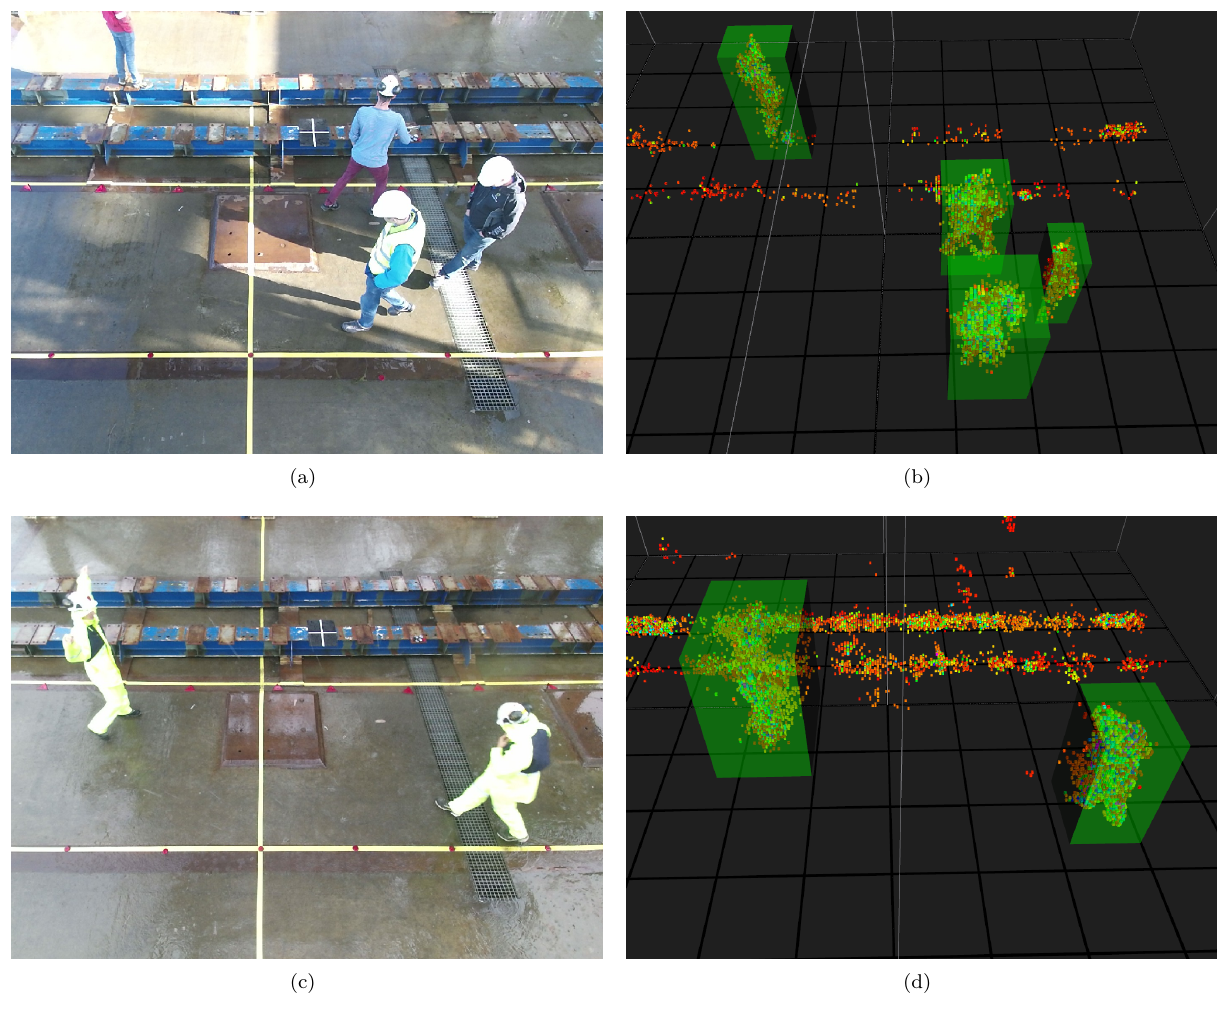
Figure 5: Detection test on Outdoor Data - (a) and (b) Four people present and detected at the test site, in low sun on wet ground; (c) and (d) Two people present and detected, in heavy